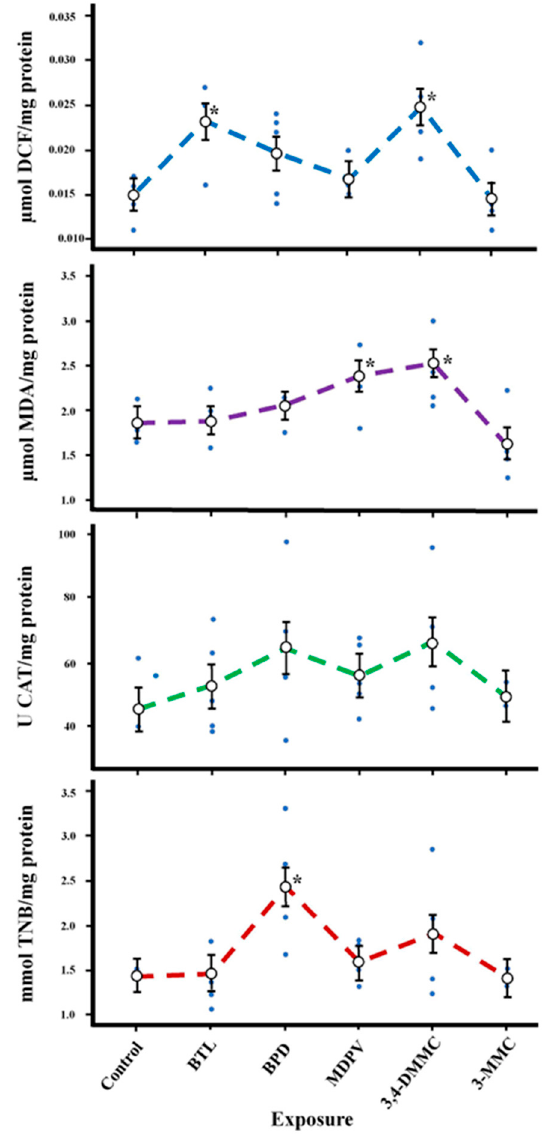
Figure 6. Biochemical effects (ROS, TBARS, CAT, and AChE) on Daphnia magna at day 8 of exposure to BTL, 3,4-DMMC, 3-MMC, MDPV, and BPD. (Asterisks (*) represent significant differences compared to the control).